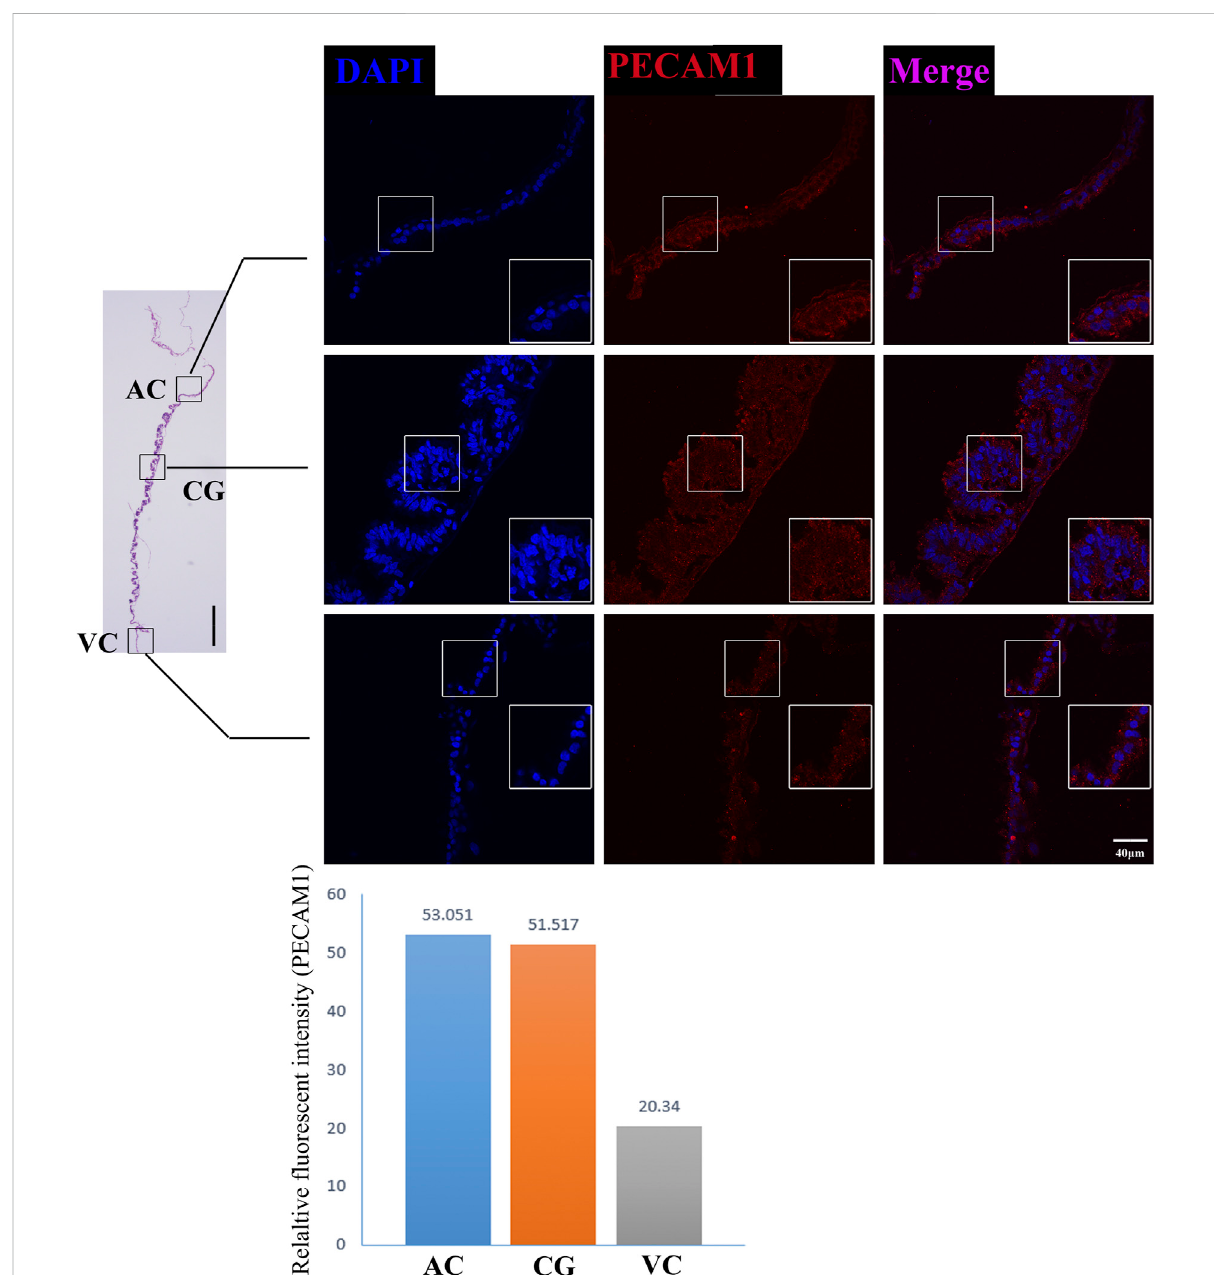
PECAM1immuno fl uorescenceonday30equinechorion.Histologicalimagesincludingallantochorion(AC),chorionicgirdle(CG),andvitelline- chorion (VC) are used to clarify the location of the immuno fl uorescence view. Below, the histogram shows the fl uorescence intensity for red fl uorescence of PECAM1. An enlarged view of the area is shown in the white frame. Left bar = 400 μ m, right bar = 40 μ